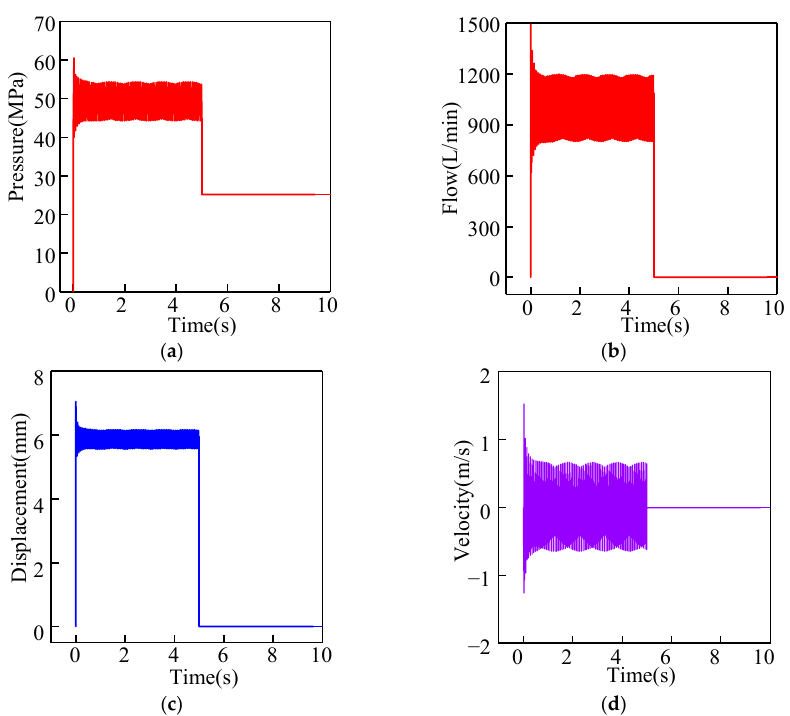
Figure 12. ( a ) Relief valve pressure. ( b ) Relief valve flow. ( c ) Displacement at the spool. ( d ) Velocity at the spool.